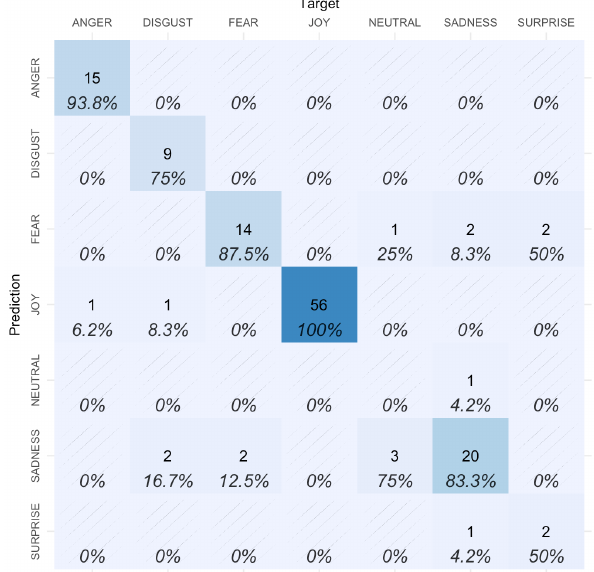
Figure 6. Confusion matrix of the emotions’ classification performed by the CNN model (darker colors correspond to higher accuracy).